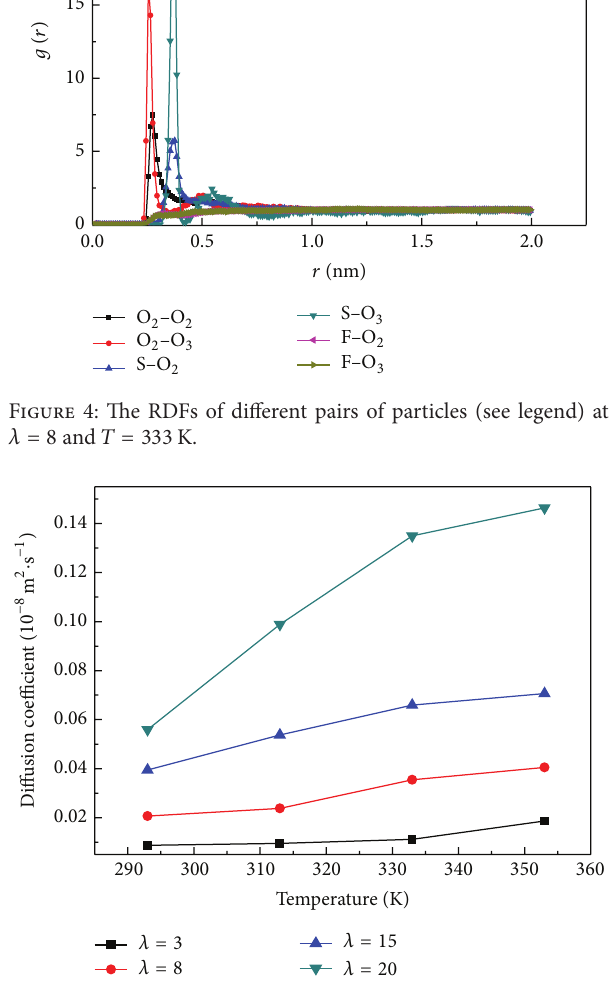
Figure 5: The variations in the diffusion coefficient of hydrated ion with the cell temperature at different water contents (𝜆 s )